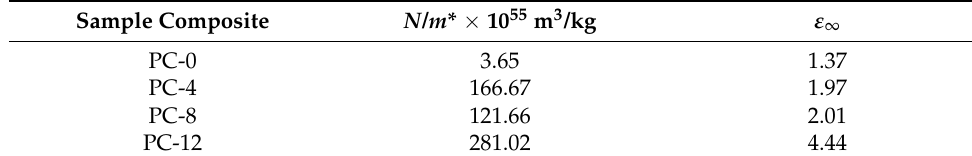
Table 5. Optical dielectric parameters associated with pure PVA and PVA containing PbS.